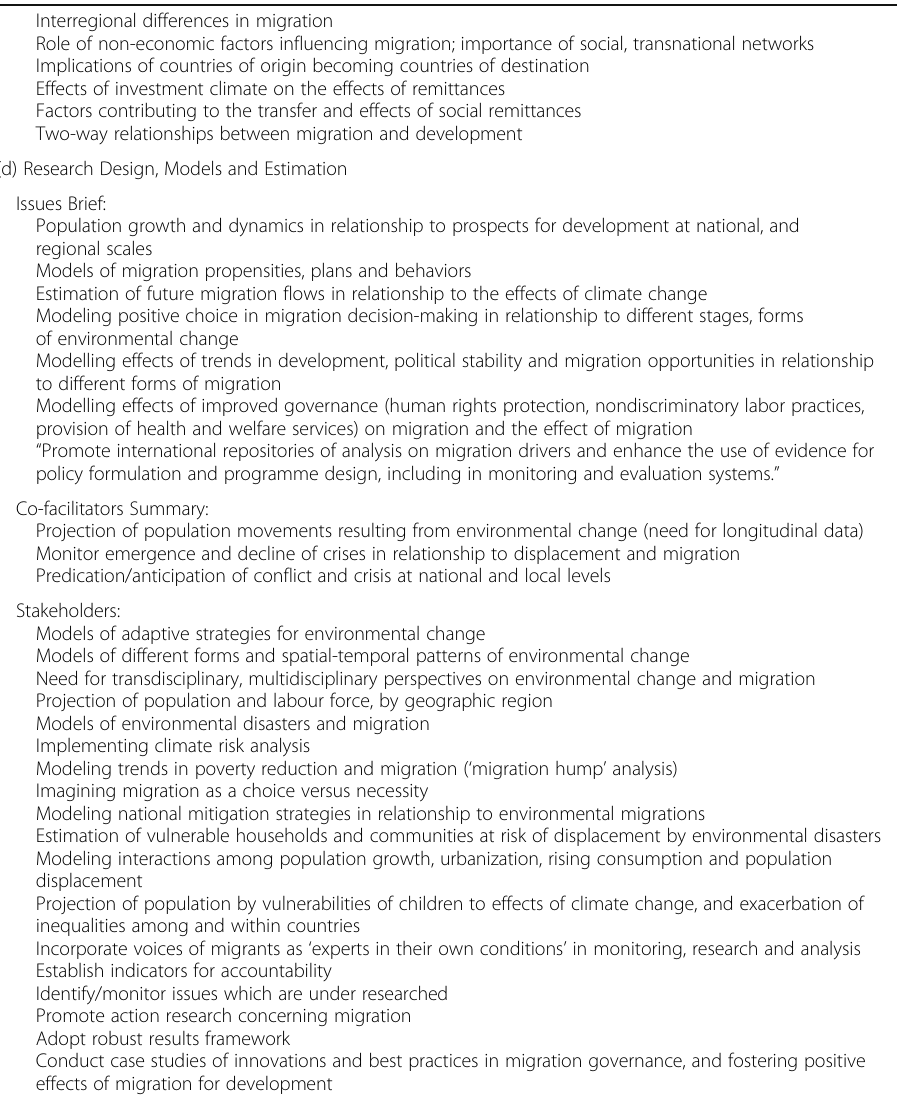
Table 2 Proposals for data and research: Thematic Session II Addressing drivers of migration, including adverse effects of climate change, natural disasters and human-made crises, through protection and assistance, sustainable development, poverty eradication, conflict prevention and resolution